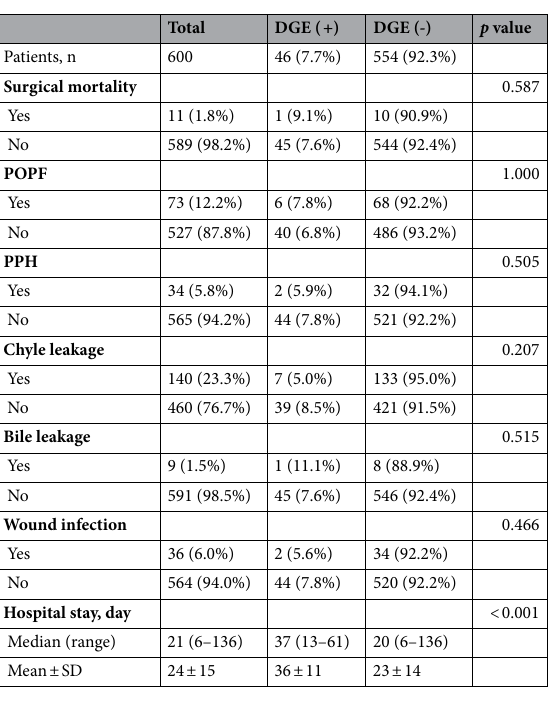
Table 4. Postoperative factors for DGE after pancreaticoduodenectomy. DGE delayed gastric emptying, POPF postoperative pancreatic fistula, PPH postpancreatectomy hemorrhage, SD standard deviation.